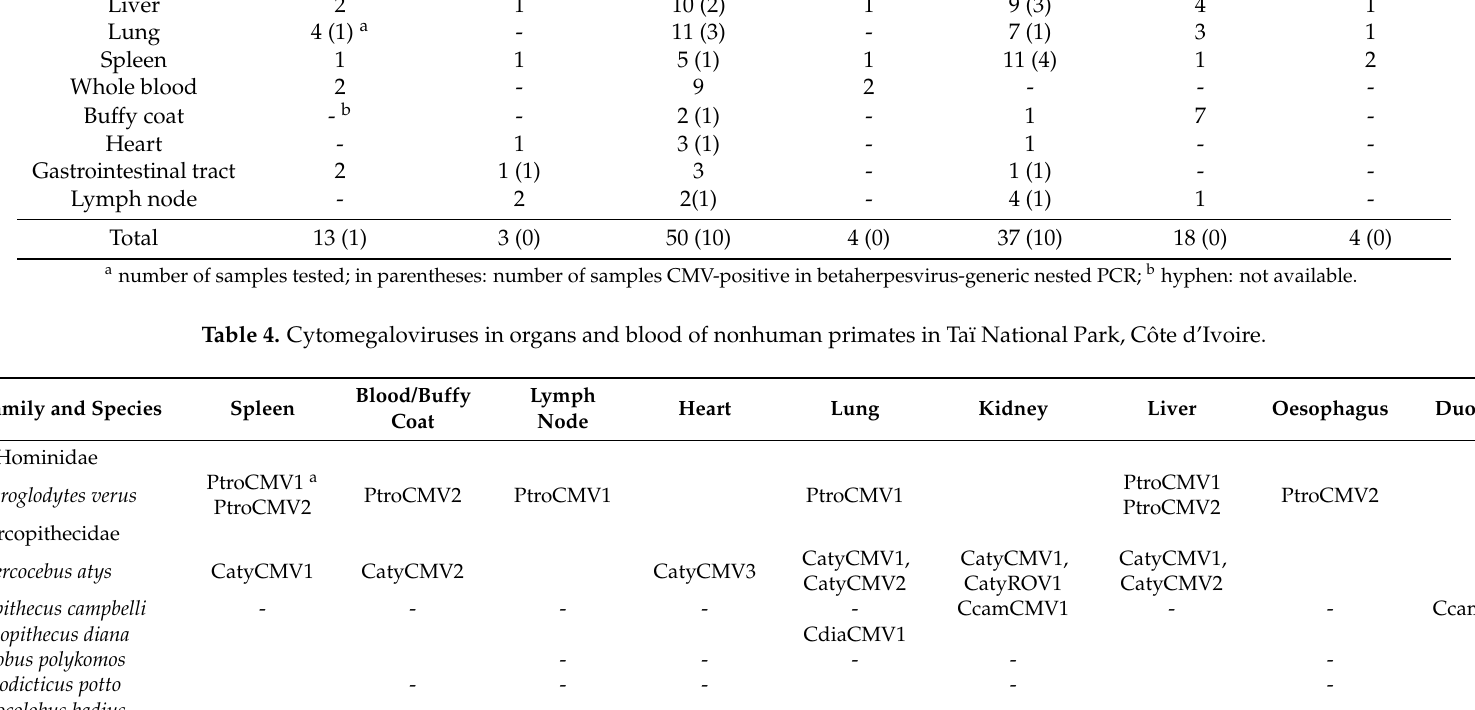
Table 3. Cytomegalovirus test results for organ and blood samples from nonhuman primates in Taï National Park, C ô te d’Ivoire. Cercopithecus Tissue diana